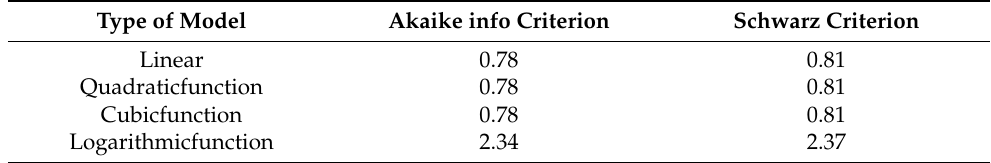
Table 6. Results of regression